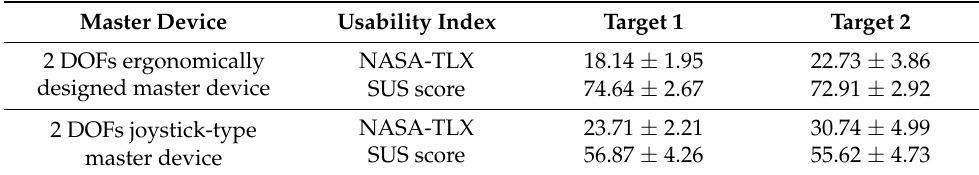
Table 1. Overall workload and system integration scores for pig hepatic artery and splenic artery experiments (mean and standard